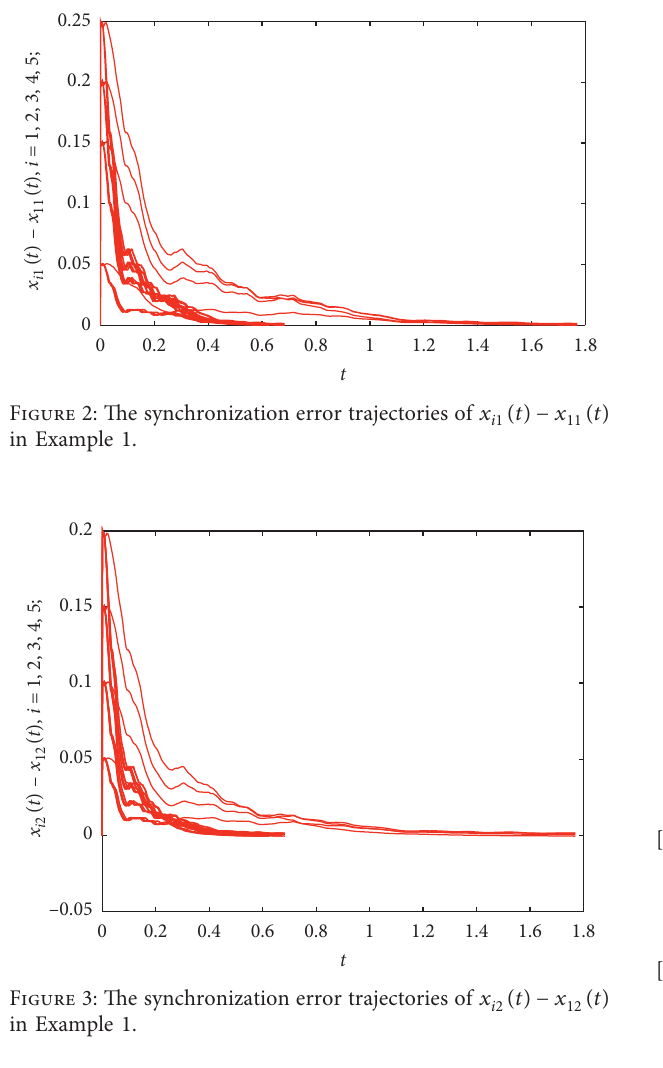
( t ) in Example 1. ij